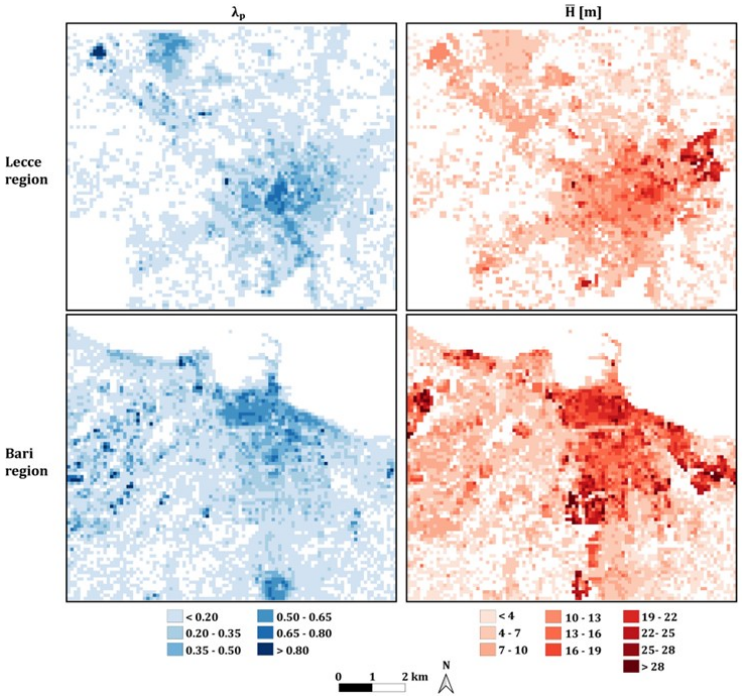
Figure 4. Maps of plan area index, λ p , and mean building height, 𝐻(cid:3365) , for the Lecce and Bari regions.